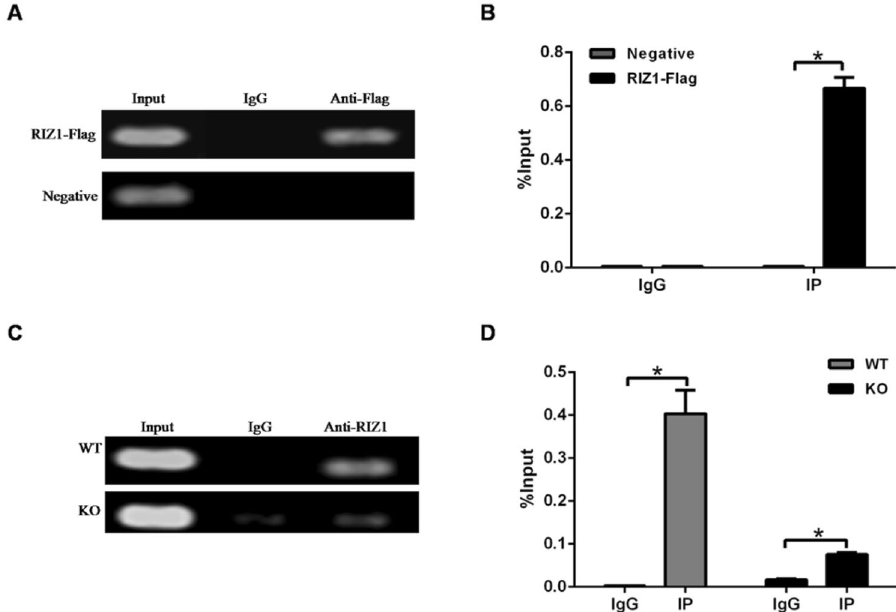
Figure 3. Akt3 gene promoter ChIP assay. ( A ) ChIP in transfected cells. HEK293 cells were transfected with pcDNA3.1/RIZ1-Flag or pcDNA3.1 vectors (Negative). PCR was performed using primers encompassing human Akt3 promoter region CpG 166 (chr1:243849411-243851290). ( B ) ChIP-qPCR assay in transfected cells. Data represent mean ± SD of triplicate measurements. * p < 0.05. ( C ) ChIP in mouse tissues. Liver tissues from 5 weeks old RIZ1 WT and KO mice were used for ChIP assay. PCR was performed using primers encompassing mouse Akt3 promoter region CpG 146 (chr1:177257300-177259121). ( D ) ChIP-qPCR assay in mouse livers. Data represent mean ± SD of triplicate measurements. * p < 0.05.